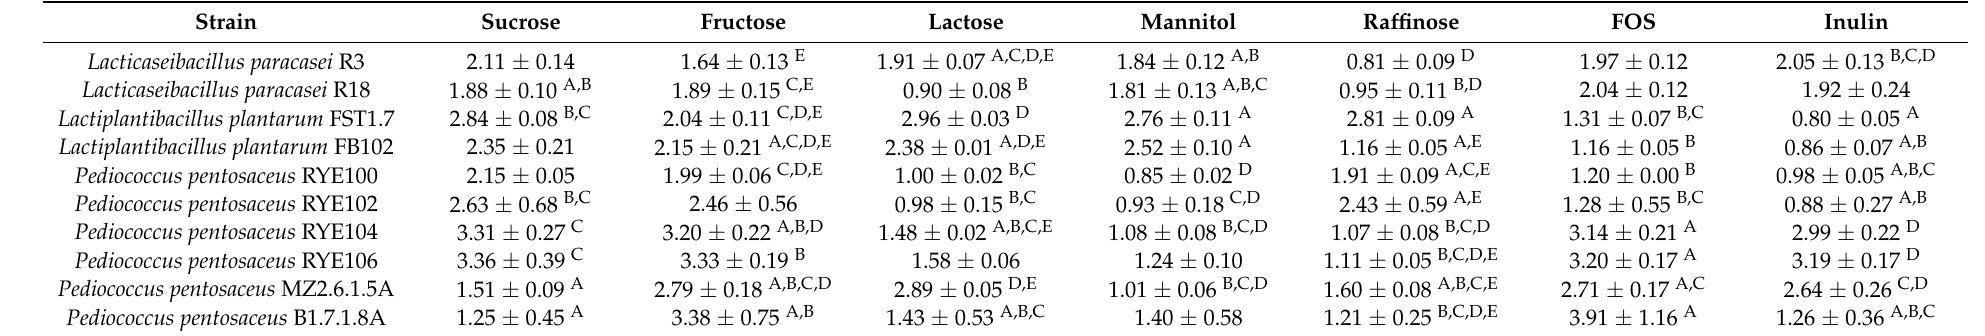
Table A1. Normalised OD (OD NORM = OD FODMAP /OD mMRS ) of selected homofermentative lactic acid bacteria in FODMAPs during 72 h incubation at 30 ◦ C